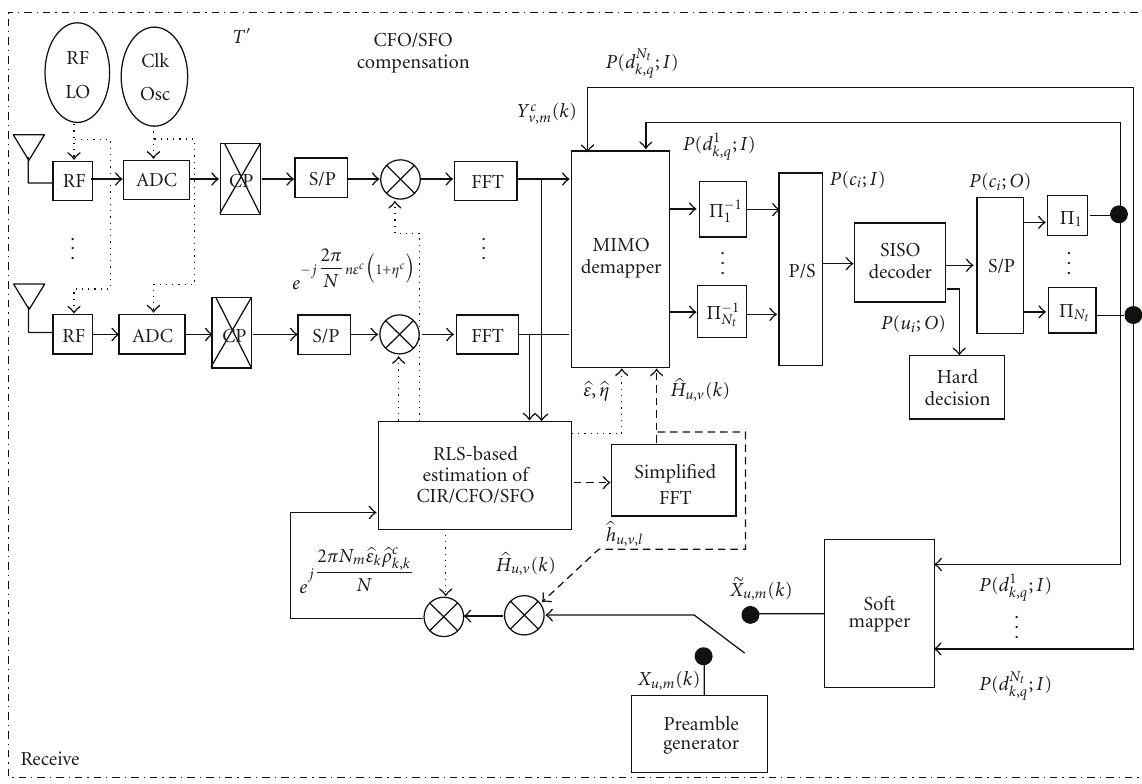
Figure 2: MIMO-OFDM receiver using turbo joint decoding, synchronization, and channel